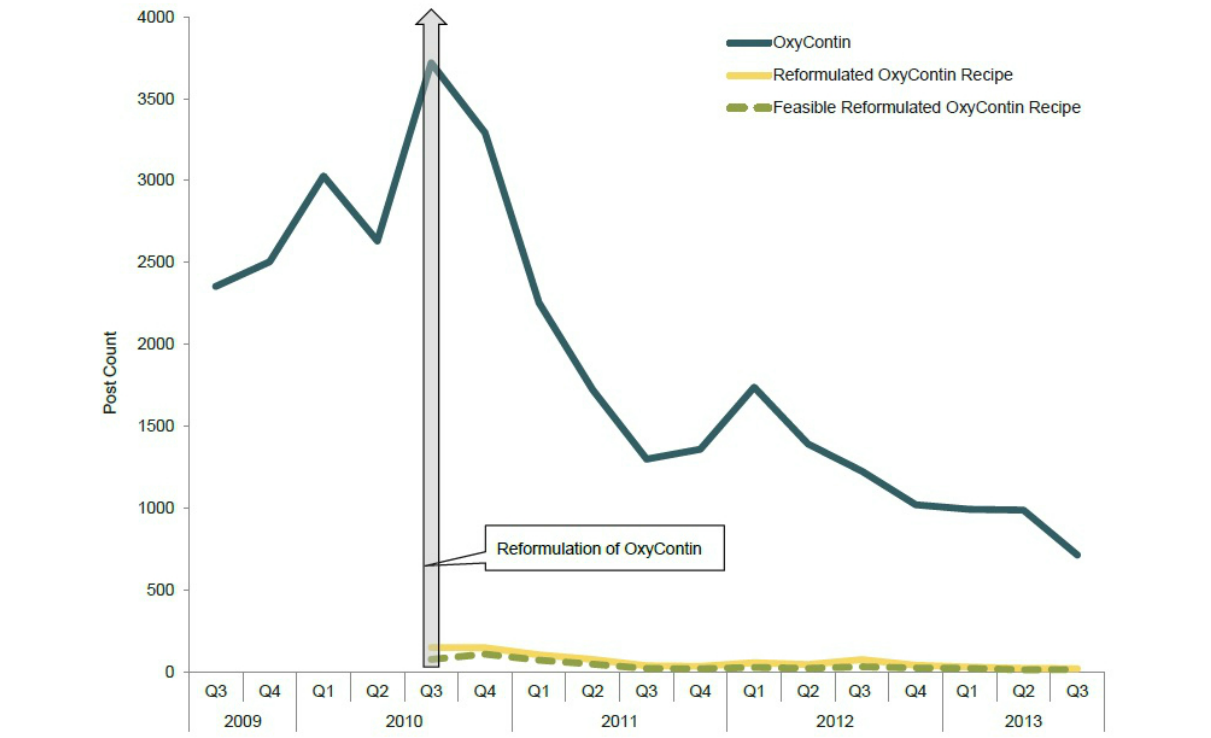
Figure 4. Frequencies of OxyContin-, reformulated OxyContin recipe-, and feasible reformulated OxyContin recipe-related posts from Q3 2009 to Q3 2013. For the reformulated OxyContin recipe and feasible OxyContin recipe categories, Q3 2010 includes data from August 9, 2010 to September 30,